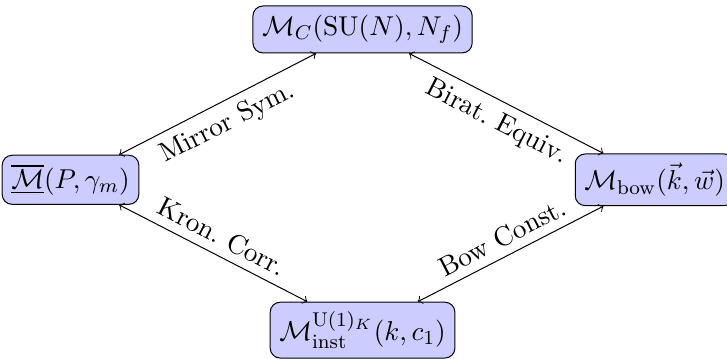
Figure 4 . This graph shows the dualities between the moduli space of reducible singular monopoles ( M ), Coulomb branch of 3D N = 4 SU( N ) gauge theories with fundamental matter ( M C ), bow moduli spaces ( M bow ), and the moduli space of U(1) K -invariant instantons on Taub-NUT ( M U(1) K